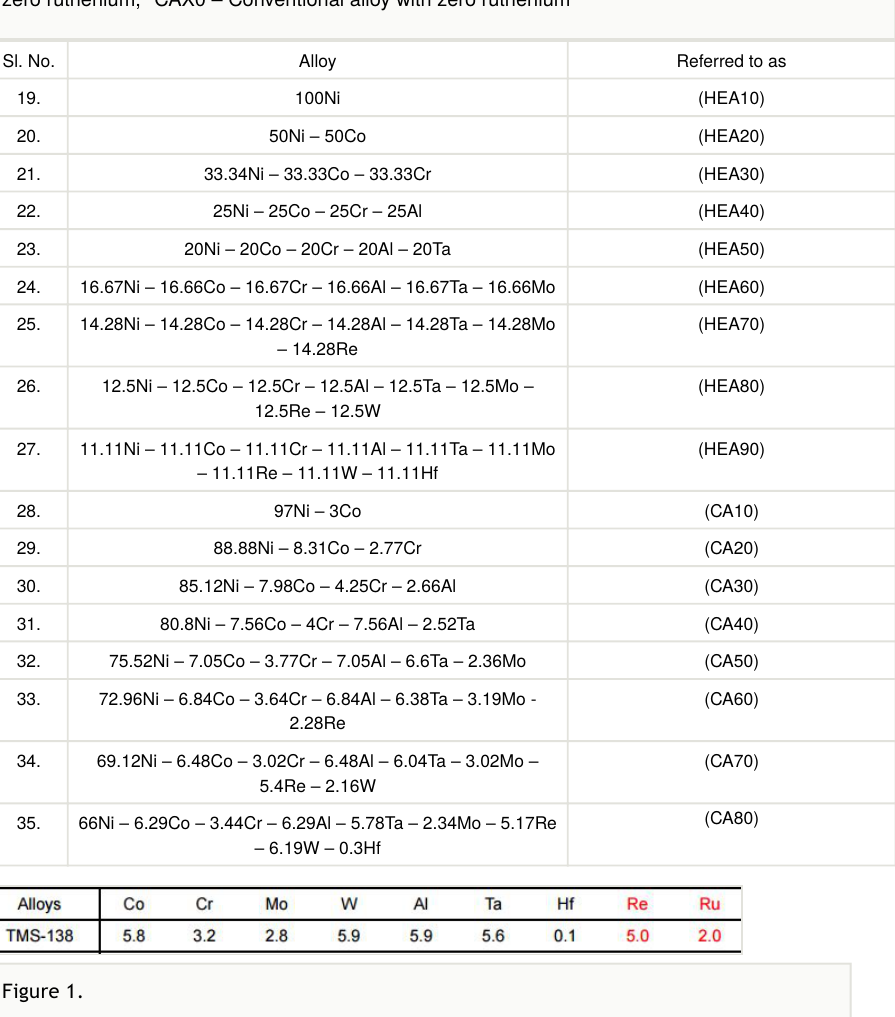
Table 2. Design of alloy compositions that does not contain ruthenium. *HEAX0 – High entropy alloy with